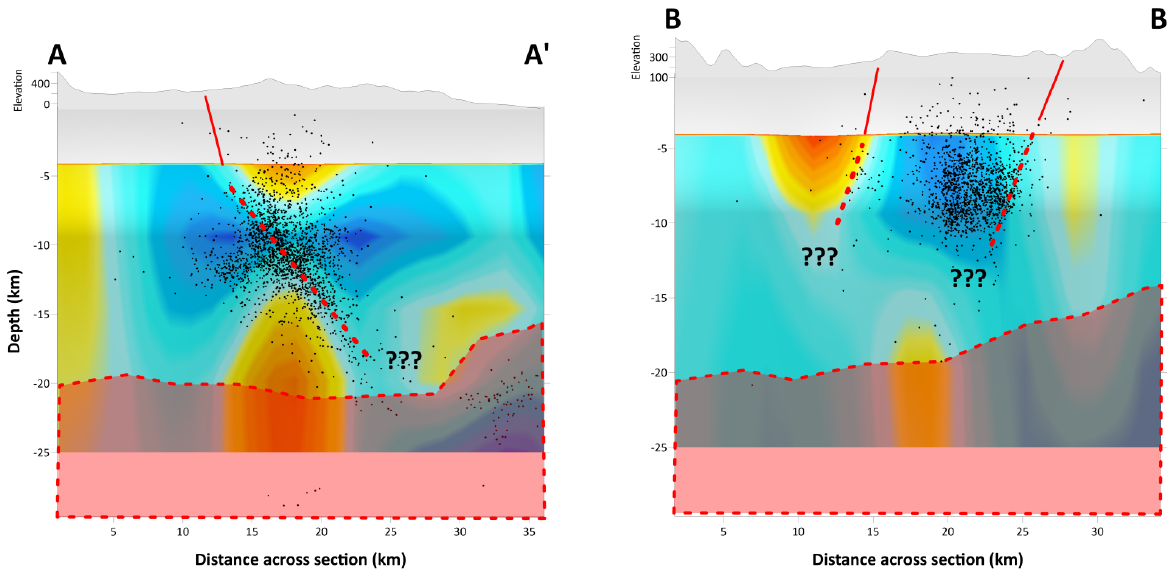
Figure 9. Cross-sections of vs. (%) perturbations. The cross-section traces are the same with the first four ones of Figure 5. 4. Co-Seismic Ground Deformation To study the co-seismic ground deformation on the epicentral area of the 27 Sep- tember 2021 event, we combined space and ground-based geodetic techniques. Radar satellite data were used to produce differential interferograms to spatially study the co-seismic deformation. Moreover, geodetic data from continuous Global Navigation